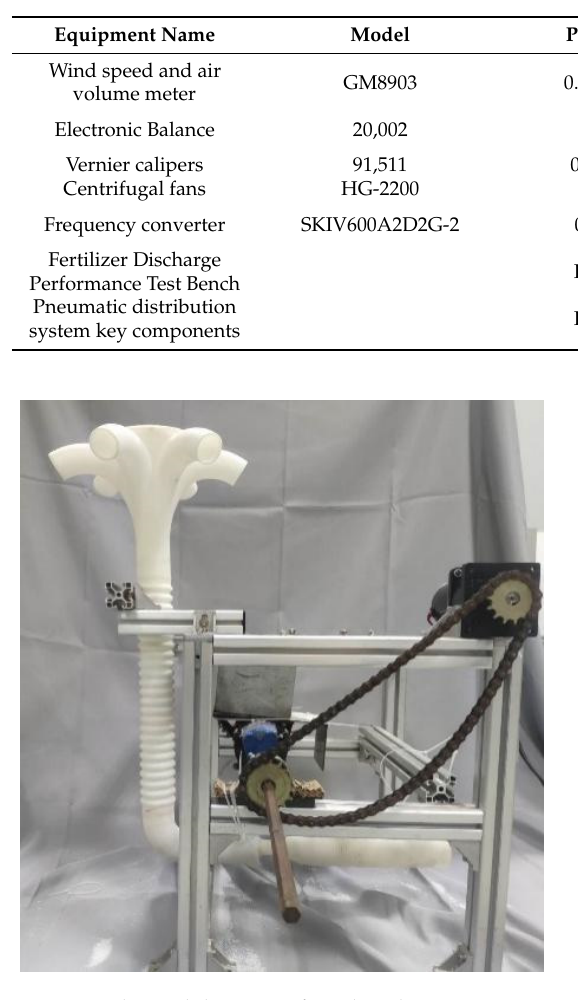
Table 4. Experiment material.